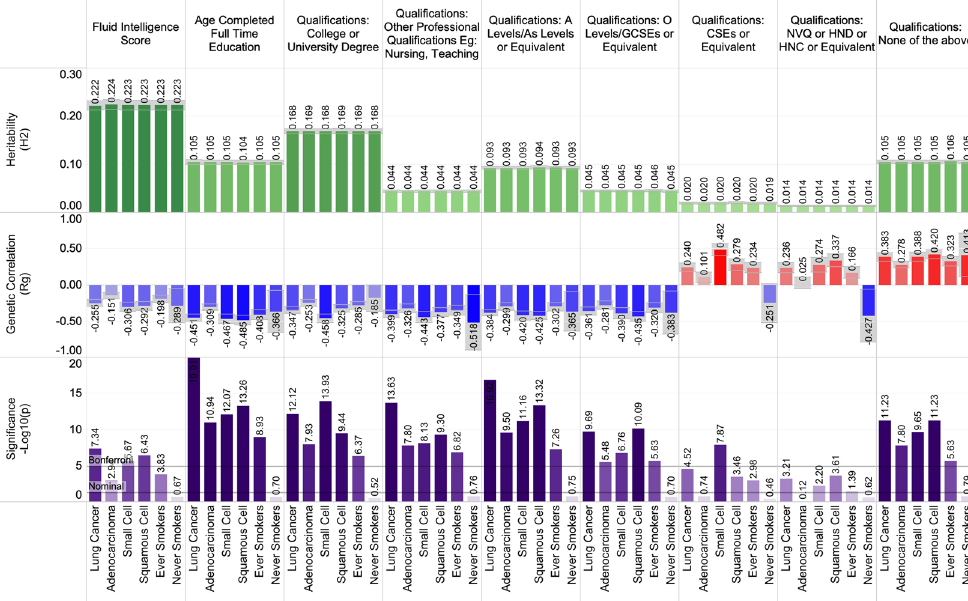
Figure 3. The shared heritability and genetic correlation between education and employment with lung